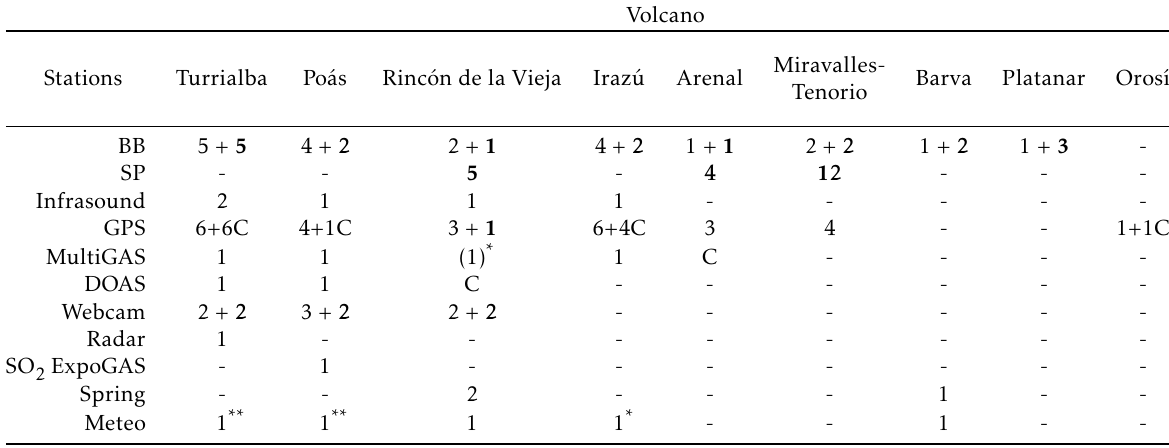
Table 1: Distribution of the volcano-monitoring network managed by OVSICORI-UNA (normal) and RSN (UCR-ICE) ( bold ) in 2019. BB = Broadband seismometers; SP = Short-period seismometers; C =